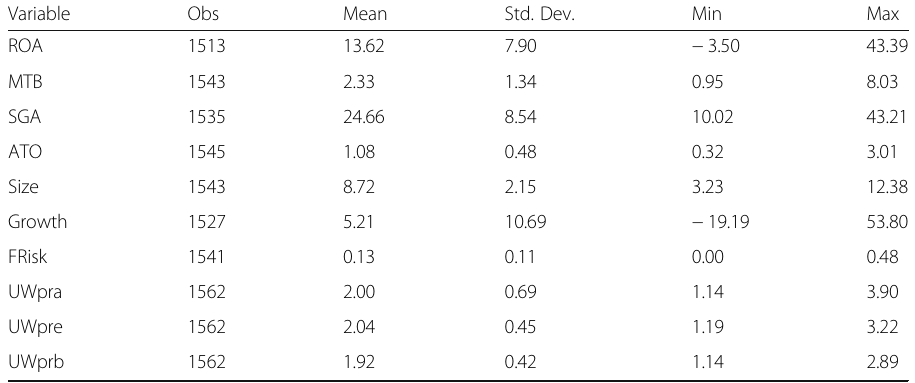
Table 2 Descriptive statistics of sugar-using publicly traded firms from Q1 2000 to Q4 2017